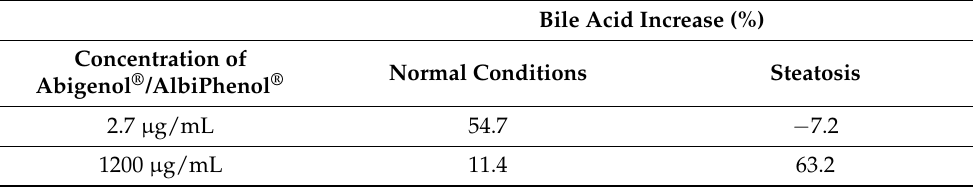
Figure 11. Bile acids in HepG2 cells after a protective treatment with Abigenol ® /AlbiPhenol ® (24 h with the formulation, followed by 24 h with the formulation + oleic acid). Bile acids were normalized on protein content in samples. Ctrl: control (untreated cells); AO: oleic acid. (n = 3). Table 6. Bile acid increase (%) in the presence of the extract compared to the untreated controls.